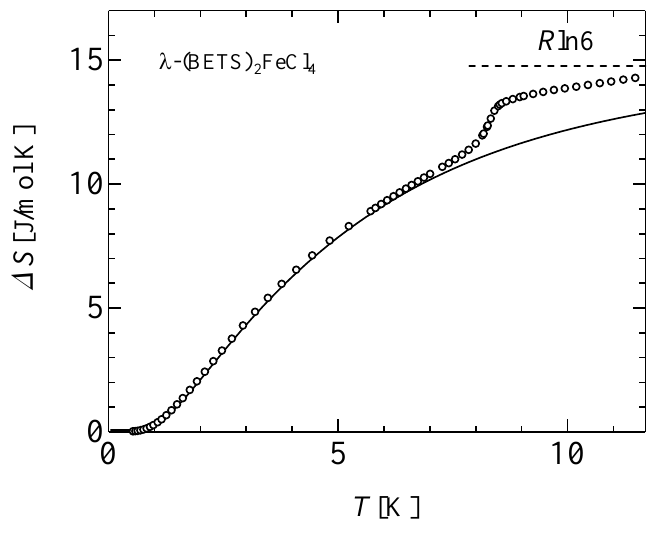
Figure 3. Temperature dependencies of spin entropy of λ-BETS Δ C (○), calculated from specific heat of Schottky-type (solid curves). The dashed line shows the degrees of freedom for 3 d spins. Reproduced with permission from JPSJ